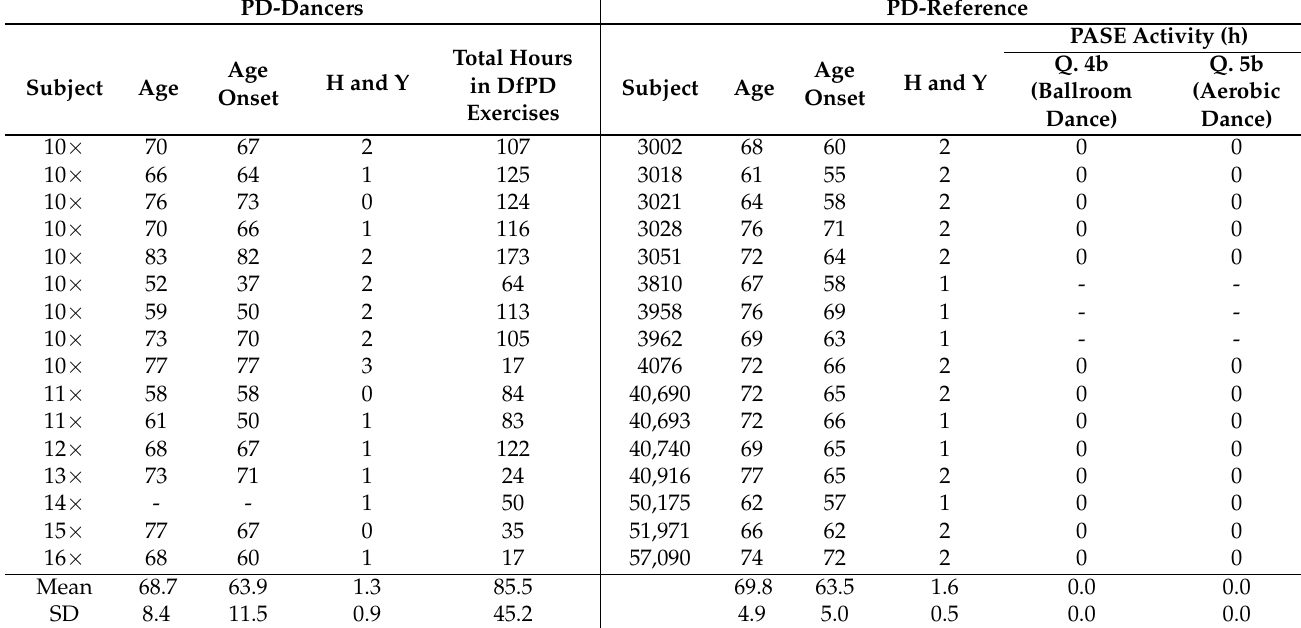
Table 1. Characteristics of people with Parkinson’s disease (PwPD) in the PD-Dancer and PD-Reference groups. PD-Dancers